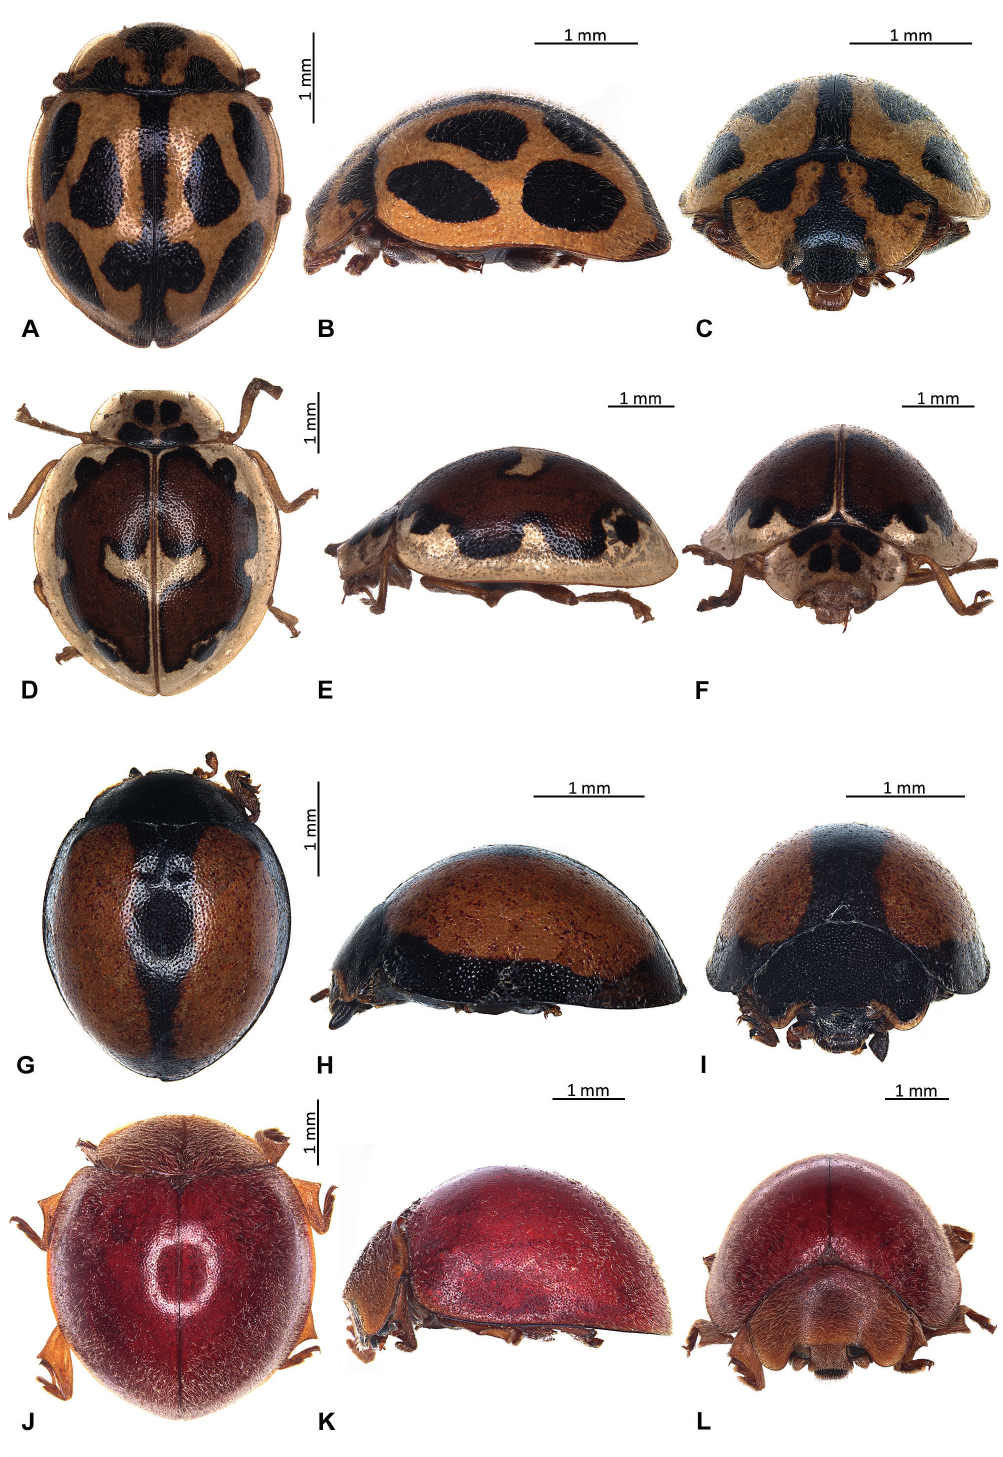
Fig. 5. Habitus. A–C . Eupalea borowieci sp. nov., ♂, holotype (MNHW). A . Dorsal view. B . Lateral view. C . Frontal view. D–F . Psyllobora marshalli Crotch, 1874, sex (MNHW). D . Dorsal view. E . Lateral view. F . Frontal view. G–I . Chnoodes yanayacu sp. nov., ♂, holotype (MNHW). G . Dorsal view. H . Lateral view. I . Frontal view. J–L . Exoplectra misahualli sp. nov., ♂, holotype (MNHW). J . Dorsal view. K . Lateral view. L . Frontal